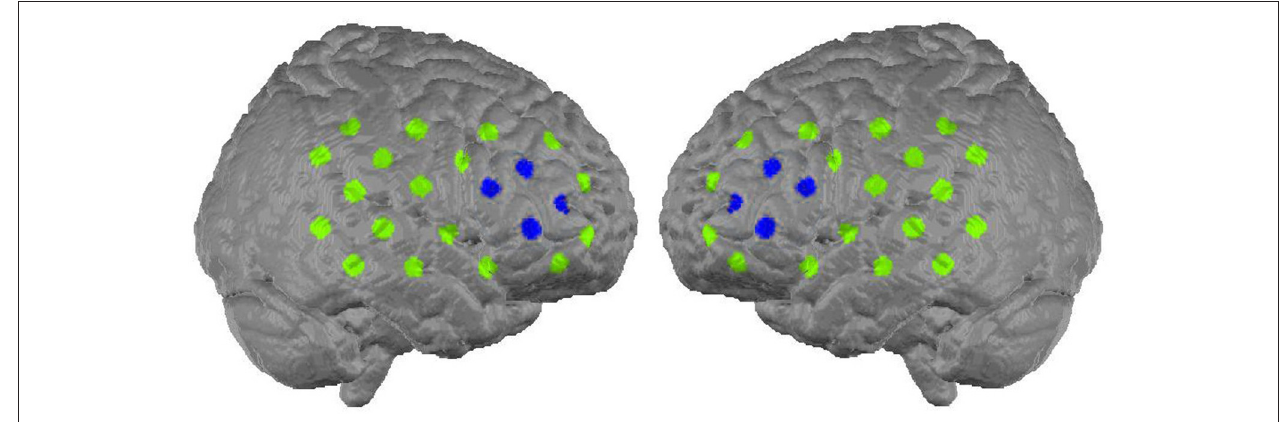
MNI coordinates, available: http://www.jichi.ac.jp/brainlab/virtual_ registration/Result3x5_E.html, Tzourio-Mazoyer et al., 2002; Tsuzuki et al.,